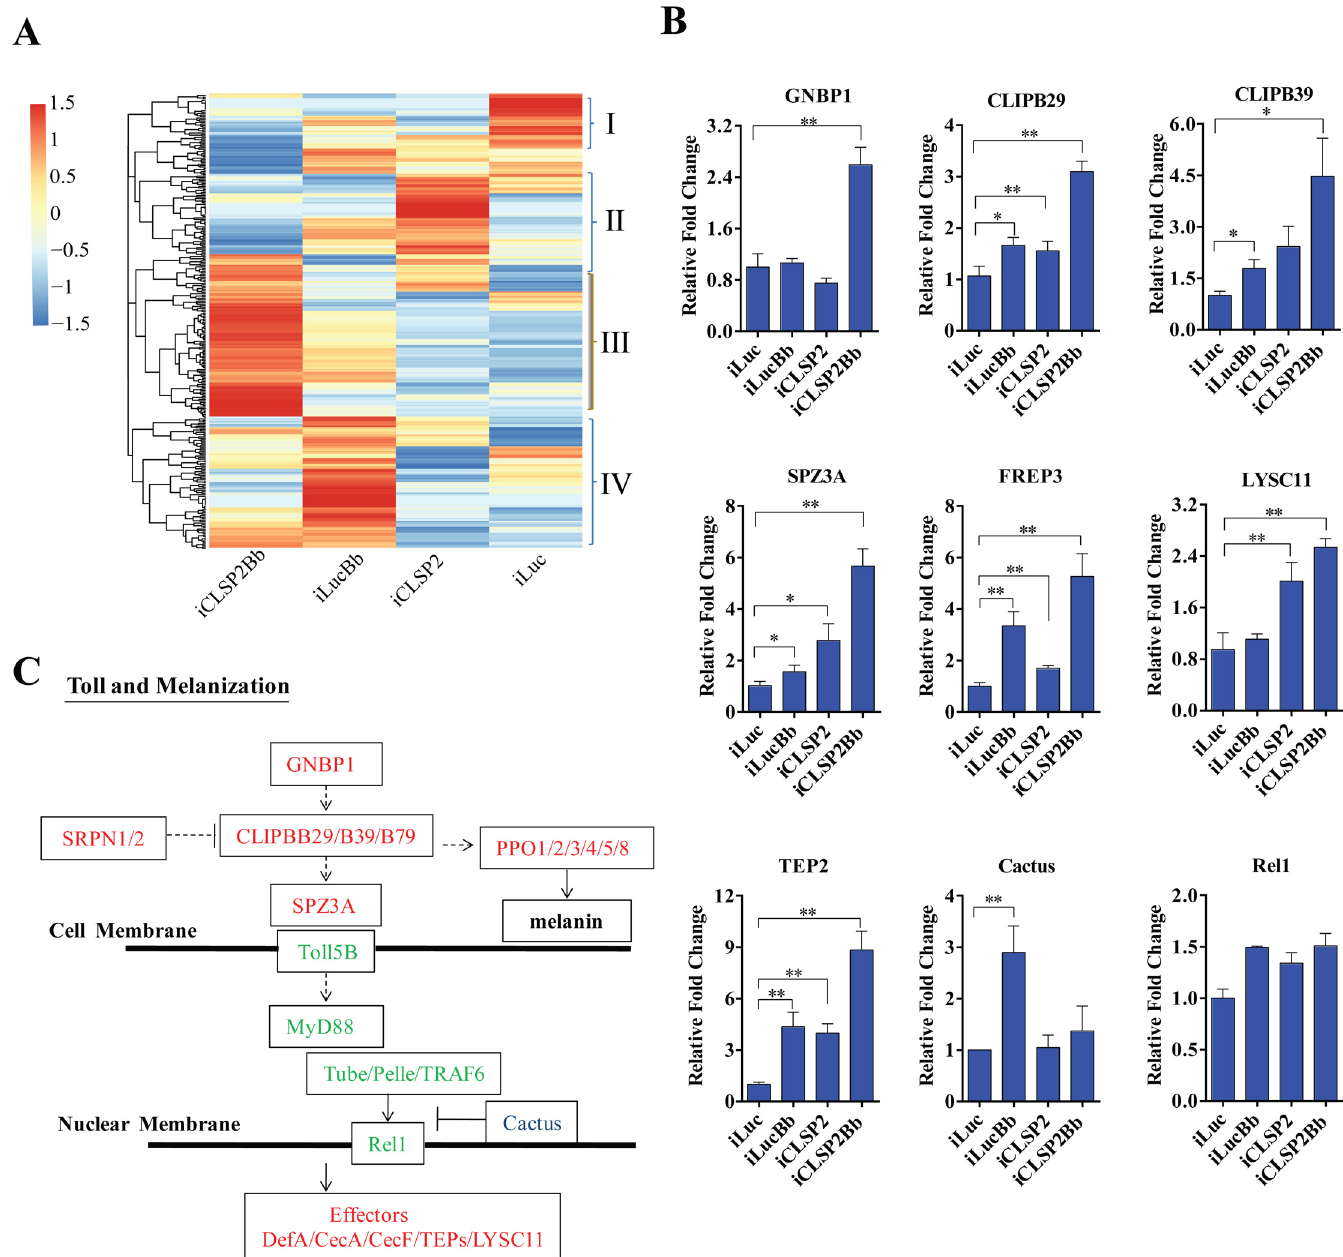
Fig 2. Transcriptome analysis of CLSP2 modulation of Ae . aegypti immune genes. A ) Hierarchical cluster analysis of gene transcripts in mosquito tissue (abdominal carcasses) after four different treatments: iLuc, iCLSP2, iCLSP2Bb, and iLucBb (left panel). Clusters I-IV represent gene cohorts that are specifically up-regulated in iLuc (Cluster I), iCLSP2 (Cluster II), iCLSP2Bb (Cluster III) and iLucBb (Cluster IV). Hierarchical cluster analysis of Cluster III immunity-related genes up-regulated in iCLSP2Bb mosquitoes is shown in S2 Fig. Transcript abundance of each gene was calculated using the RSEM software package (Trinity) and heat maps generated by R software. The color scale indicates the abundance deviation from the median for each gene. The list of up-regulated genes in each group was shown in S1 – S3 Tables. B ) Real-time RT-PCR validation of transcript levels of selected immune genes. Data were normalized to the expression level of iLuc. Data were shown as mean ± SEM. * p < 0.05; ** p < 0.01. iLucBb, iLuc mosquitoes infected with B . bassiana (24 h post infection); iCLSP2, CLSP2 dsRNA-treated mosquitoes infected with B . bassiana (24 h post infection); iCLSP2, mosquitoes injected with CLSP2 dsRNA. Control group (iLuc) was injected with luciferase dsRNA. C ) A schematic diagram of the Toll and melanization pathways. Red represents genes up- regulated in iCLSP2Bb (ratios (cid:1) 1.5 fold), while those that were not significantly affected are shown in green. Cactus, which inhibited in iCLSP2Bb, is in blue.